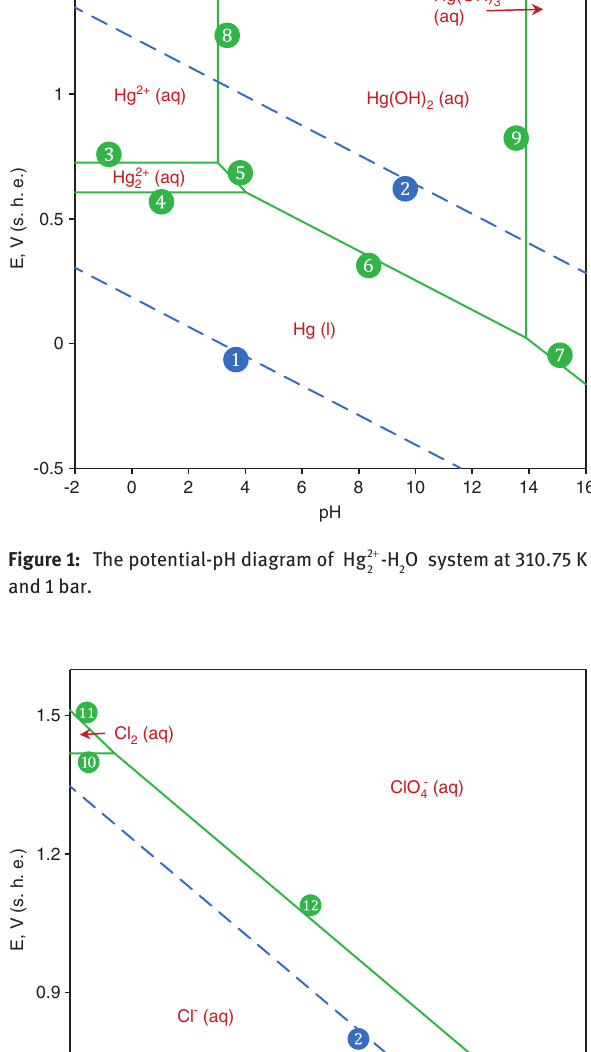
Figure 1, and the potential-pH diagram of Cl - -H O system 2 = 0.1 mol L -1 is presented in at 310.75 K, 1 bar, and a [Cl] (aq) Figure 2. The calculated characteristics of the chemical and electrochemical equilibria are listed in Table 2.